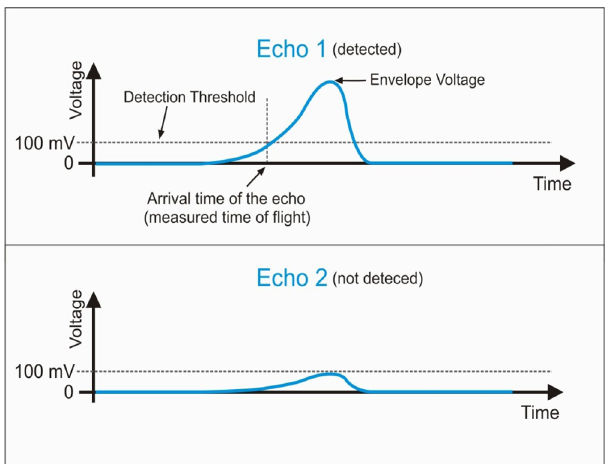
Figure 12. Detection of sonar signals and measurement threshold for the two-way travel time (time of flight). Top panel: example of a detected signal that passes the threshold of 100mV. The arrival time of the echo is measured when the signal voltage equals 100mV. Bot- tom panel: example of a weak signal that does not pass the detection threshold and hence is not recorded by the